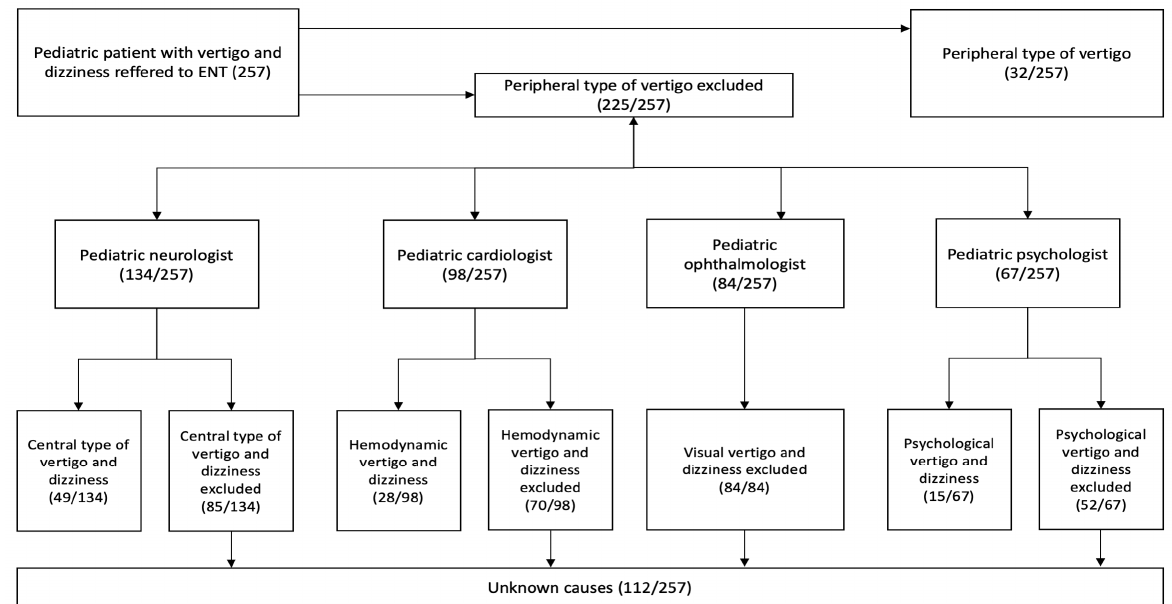
Figure 3. Flowchart showing the number of children that were referred through each of the sub-specialties. In terms of head imaging, 109 (42.4%) had an MRI of the head performed, of which 18 (16.5%) children had some pathological finding (excluding cysts of the pineal gland). 47 (18.2%) children had a CT scan done, with only two (4.2%) of them being pathological. Overall, in 20 (7.7%) children, head imaging (CT or MRI) revealed a pathology. A total of 17 (6.7%) had a head trauma preceding the onset of vertigo. Nine (4%) children had had previous intracranial operations, and seven (3%) had positive serology to Borrelia Burgdorferi . Regardless of the multidisciplinary workup, our children go through, in 43.6% of children, the etiology of vertigo and dizziness remained unknown. Figure 4 shows the etiology of pediatric vertigo and dizziness, and in Figure 5, an additional age distribution stratified by the etiology. Figure 4. The etiology of pediatric vertigo and dizziness. Numbers represent the percentage of each etiology among 257 referred children.